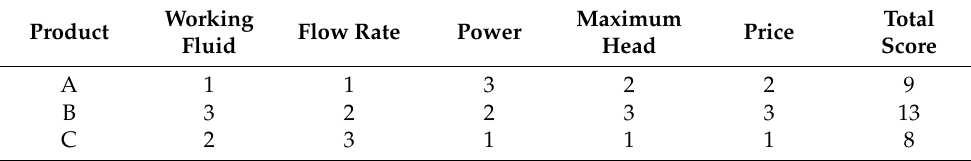
Table 4. An example of decision matrix for pump selection process. Each student involved in the project may participate in the selection process by filling out this